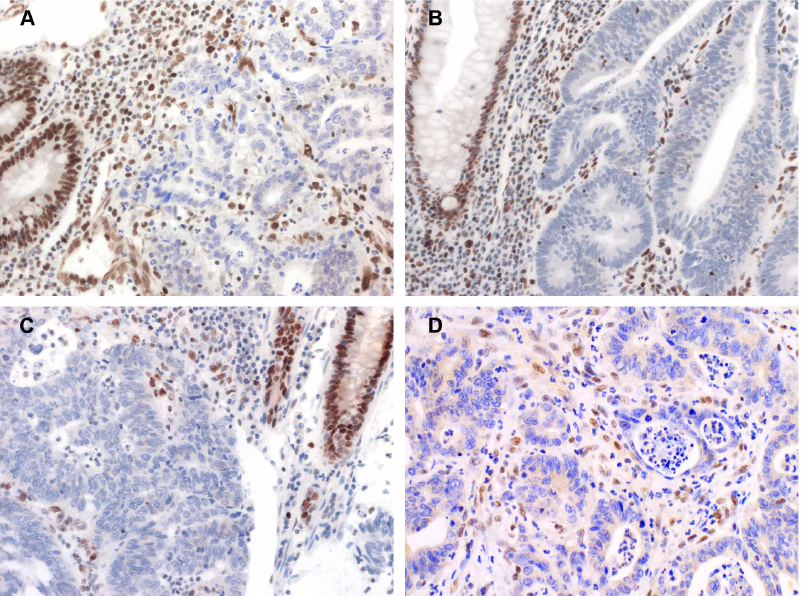
Figure 2. Examples of immunostains showing loss of MMR proteins. Positive nuclear staining in normal colonic epithelium or stromal cells and loss of expression in colorectal cancer of MLH1 (A), MSH2 (B), MSH6 (C) and PMS2 (D).